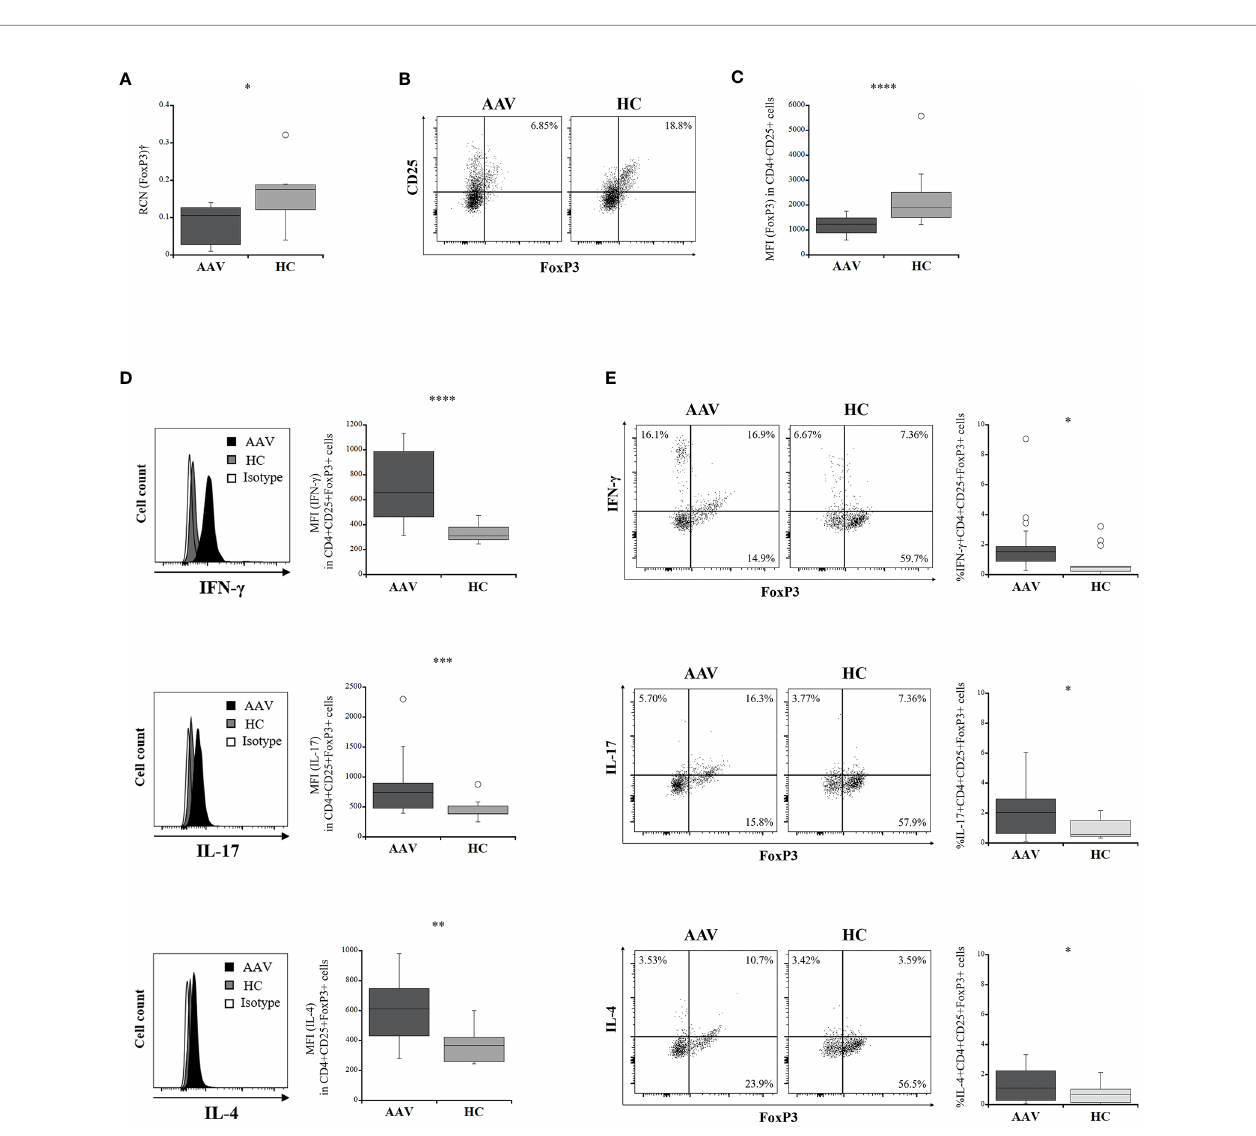
FIGURE 1 | Comparisons of intracellular expression of FoxP3 and effector cytokine levels in regulatory T cells (Tregs) between the patients with ANCA-associated vasculitis (AAV) and healthy controls (HC). (A) relative copy number (RCN) of FoxP3 in isolated Tregs (AAV, n = 10; HC, n = 7). (B) representative dot plots showing CD25+FoxP3+ in CD4+ cells. (C) the median fl uorescence index (MFI) of FoxP3 in CD4+CD25+ cells (AAV, n = 18; HC, n = 15). (D) representative histograms showing expression of interferon- g (IFN- g ), interleukin (IL)-17, or IL-4 in CD4+CD25+FoxP3+ cells (left). MFI of IFN- g , IL-17, or IL-4 in CD4+CD25+FoxP3+ cells (AAV, n = 18; HC, n = 15) (right). (E) representative dot plots showing expression of FoxP3 and interferon- g (IFN- g ), interleukin (IL)-17, or IL-4 in CD4+CD25+ cells (left). Percent frequencies of IFN- g , IL-17, or IL-4 positive CD4+CD25+FoxP3+ cells (AAV, n = 18; HC, n = 15) (right). † Isolated Tregs from peripheral blood mononuclear cells. * p < 0.05; ** p < 0.005; *** p < 0.0005; **** p <